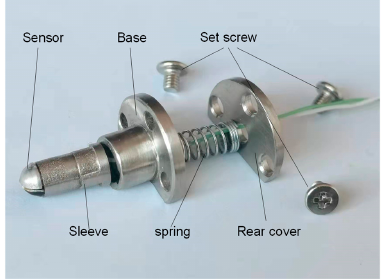
Figure 6. Actual picture of the adaptive film temperature sensor.